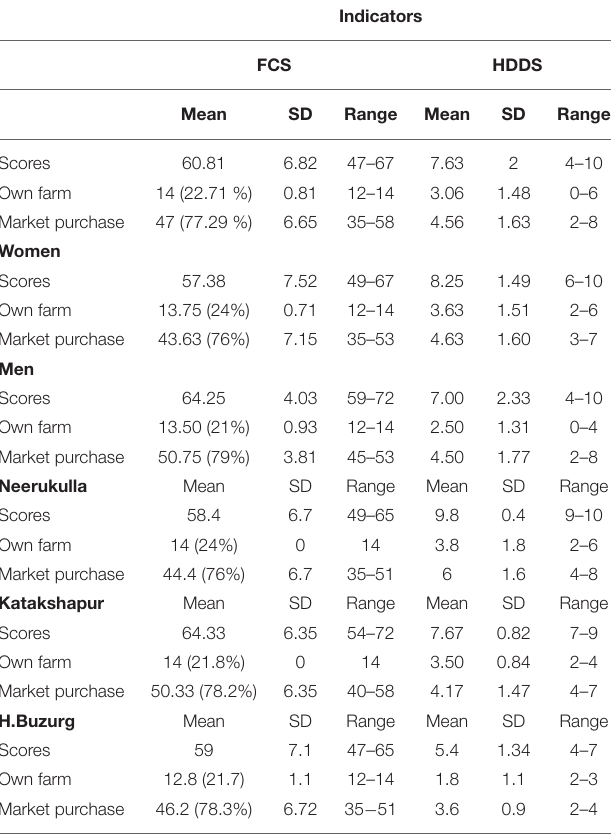
TABLE 4 | Descriptive statistics for FCS and HDDS in rural Warangal